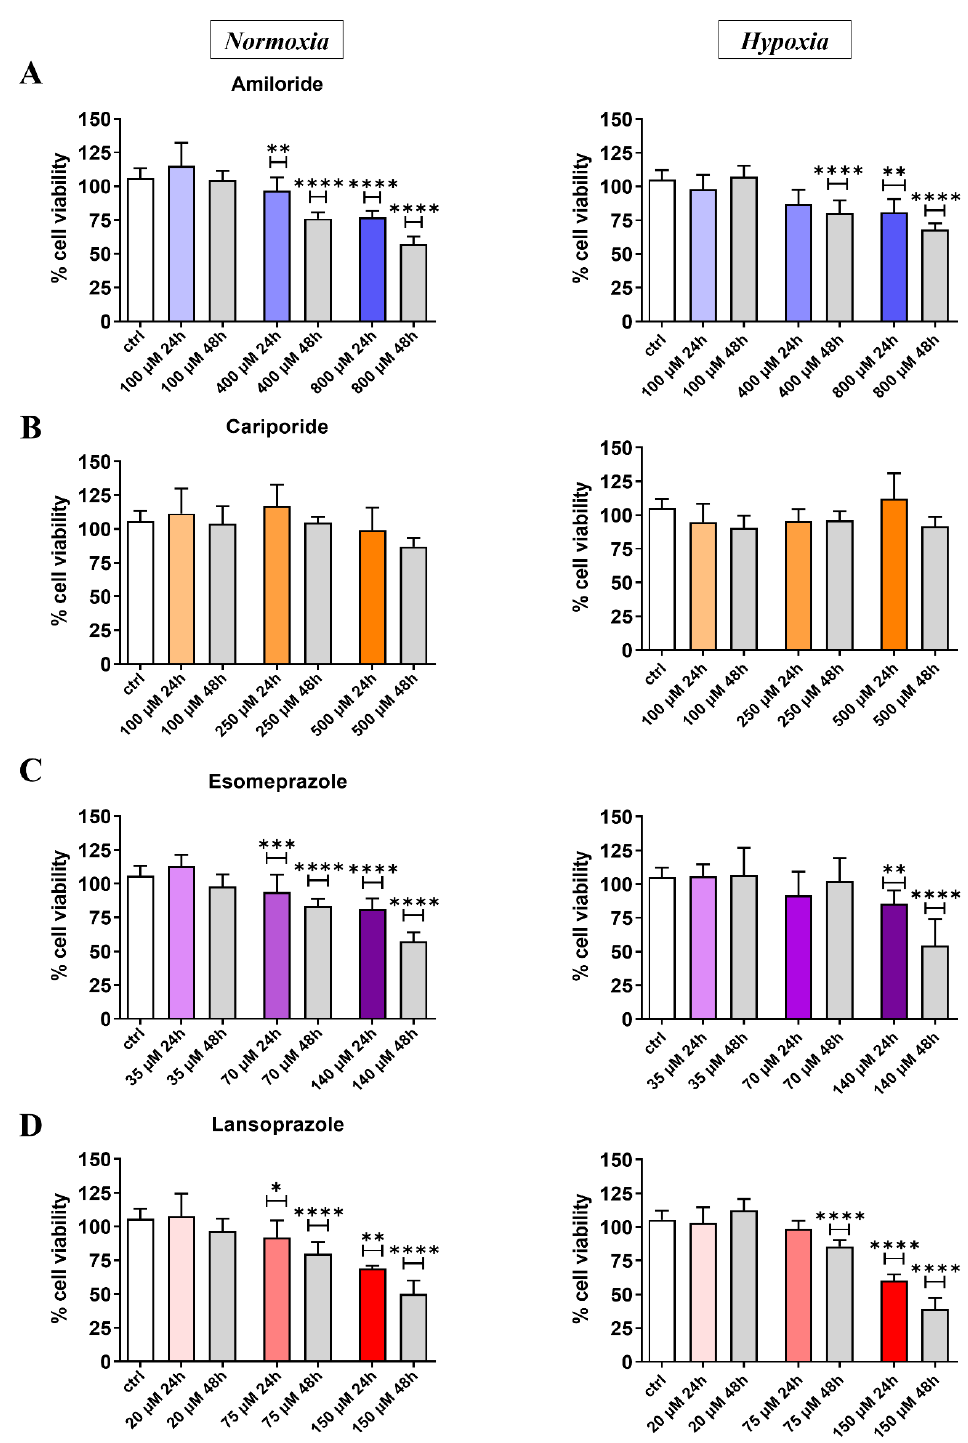
Figure 1. Cell viability results for PC3 cell line in normoxic (left column) and hypoxic (right column) conditions after 24 or 48 h upon treatment at different concentrations with Amiloride ( A ), Cariporide ( B ), Esomeprazole ( C ), and Lansoprazole ( D ), respectively. All drug concentrations are expressed in µ M units with the color intensity matching the increasing concentration for the 24 h treatment experiment. ANOVA statistical analysis with Bonferroni post-hoc correction was applied against the control group at the two different time points * p value < 0.05; ** p value < 0.01; *** p value < 0.001; **** p value < 0.0001).